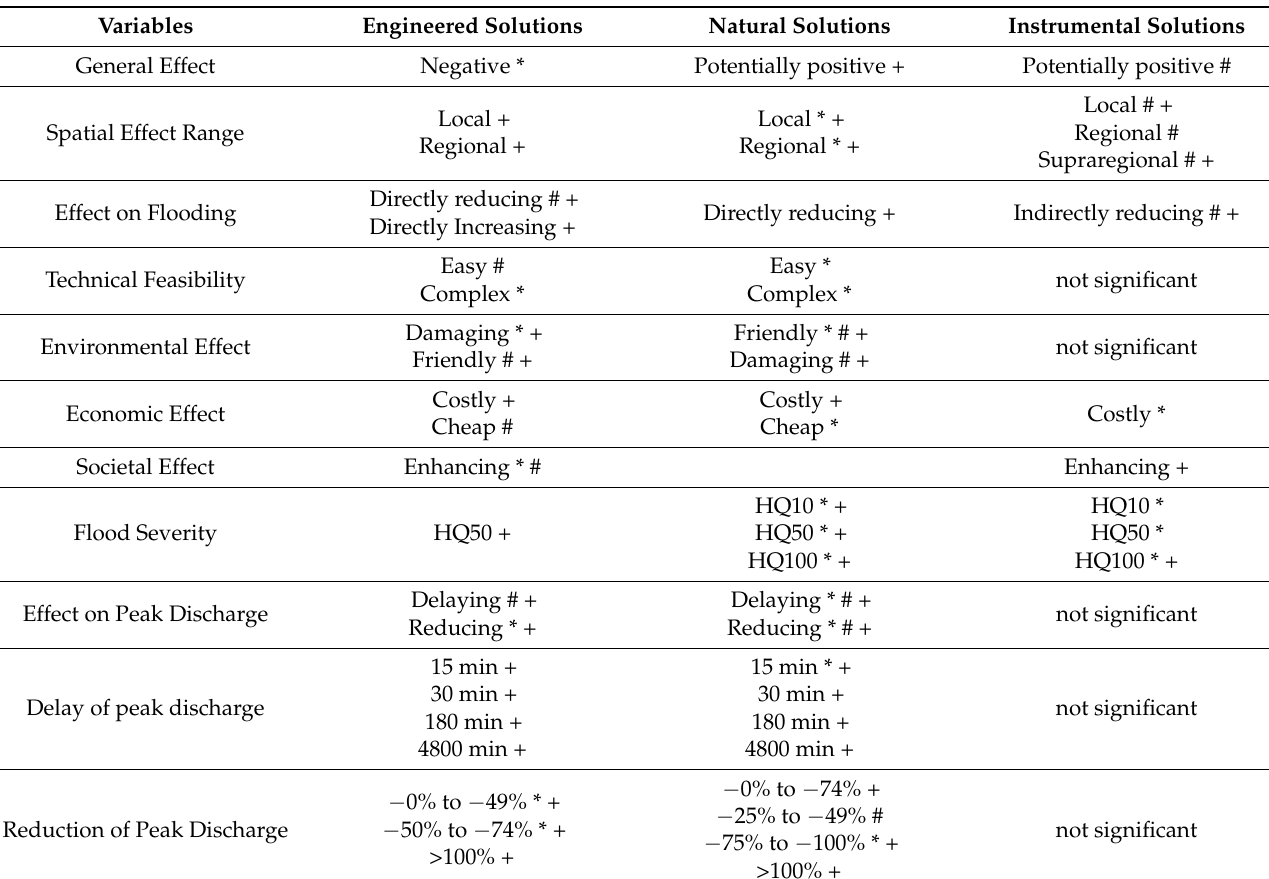
Table 5. Synthesis of the assessment of the solutions (* European rural mountainous areas, # non-European rural mountain- ous areas, + other mountainous areas). Instrumental solutions gathered: governance, urban and rural planning, and land use and land management